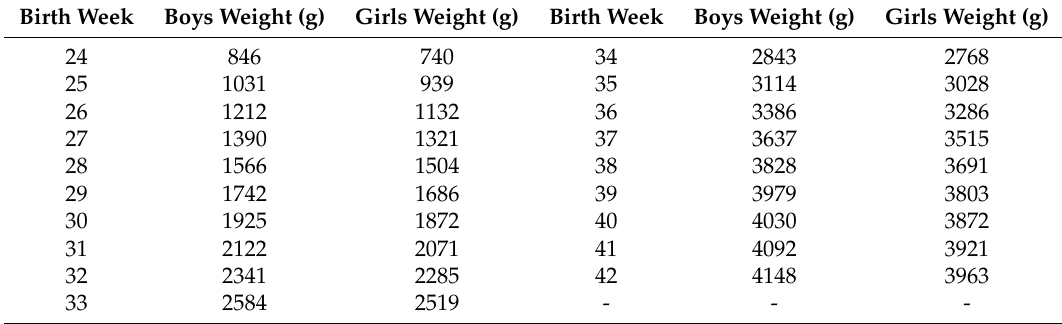
Table 1. Birthwise Large for Gestational Age infants classification chart which is a widely used and accepted guideline on the Chinese